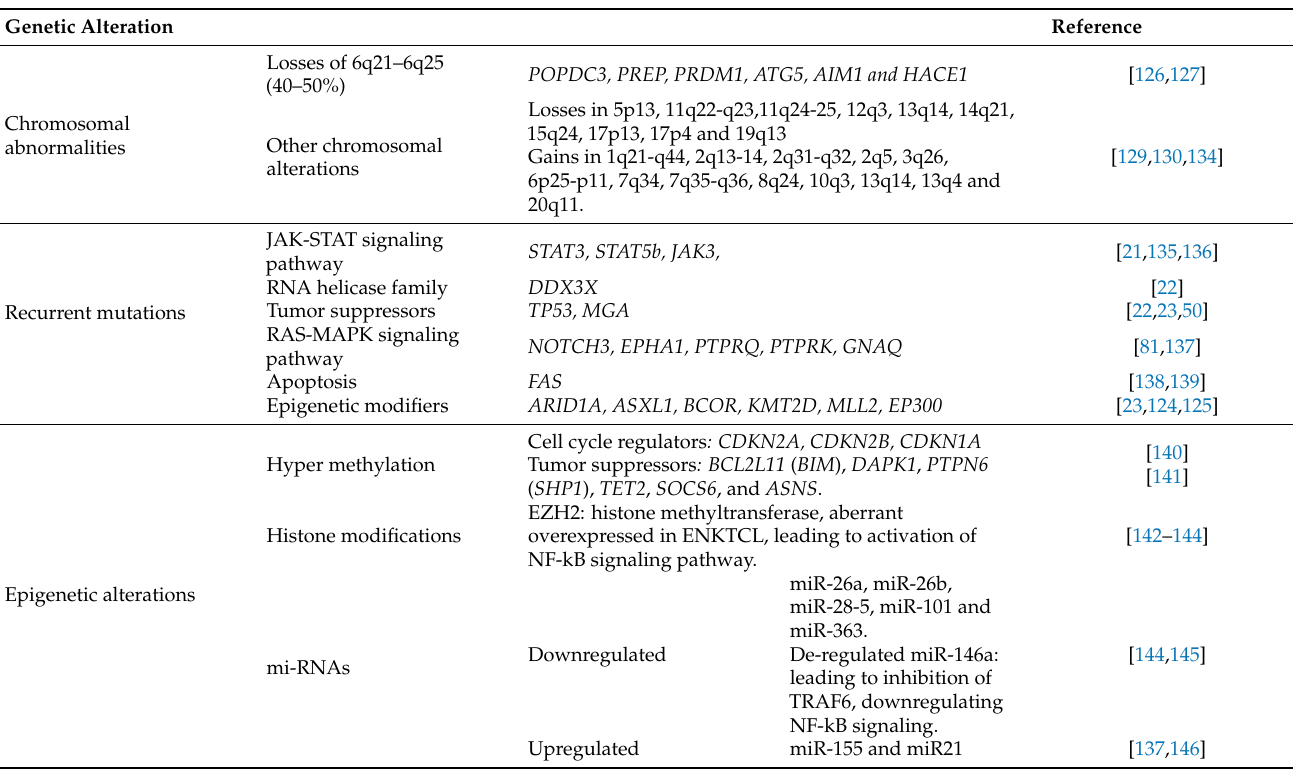
Table 3. Main genetic alterations in